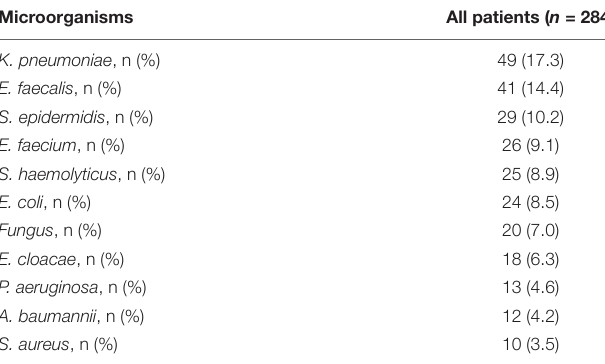
TABLE 2 | Microorganisms cultured from drainage fluid after pancreaticoduodenectomy. Microorganisms All patients ( n =